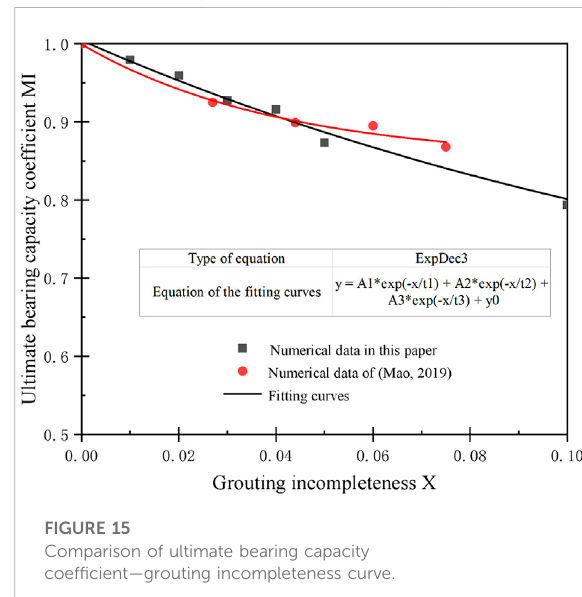
FIGURE 15 Comparison of ultimate bearing capacity coef fi cient — grouting incompleteness